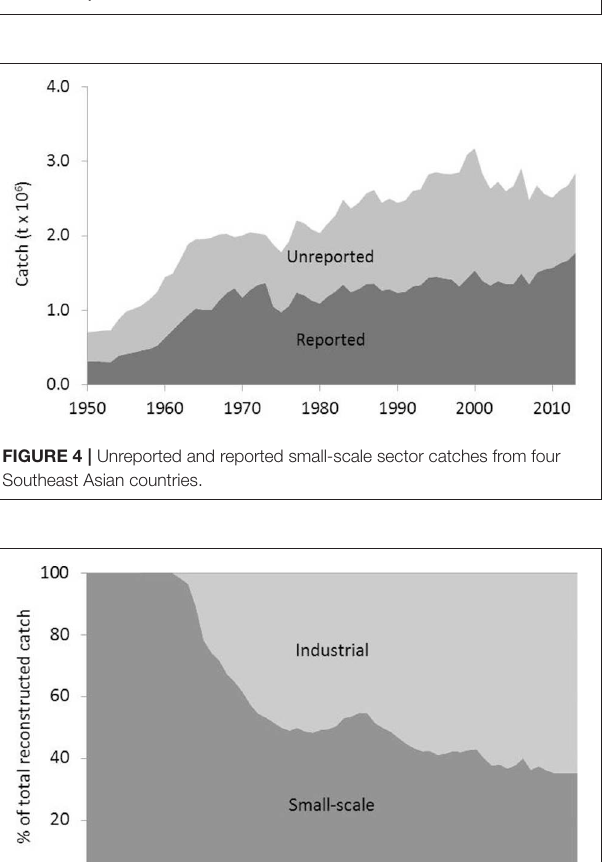
sector, small-scale fisheries remain important at the community level where they act as social safety nets (Béné et al., 2007,